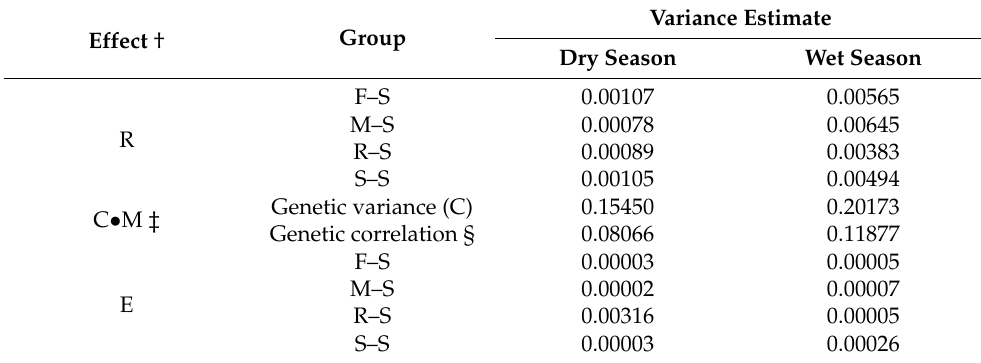
Table 5. Variance estimates (10 − 1 kg 2 ha − 2 ) for the C • M